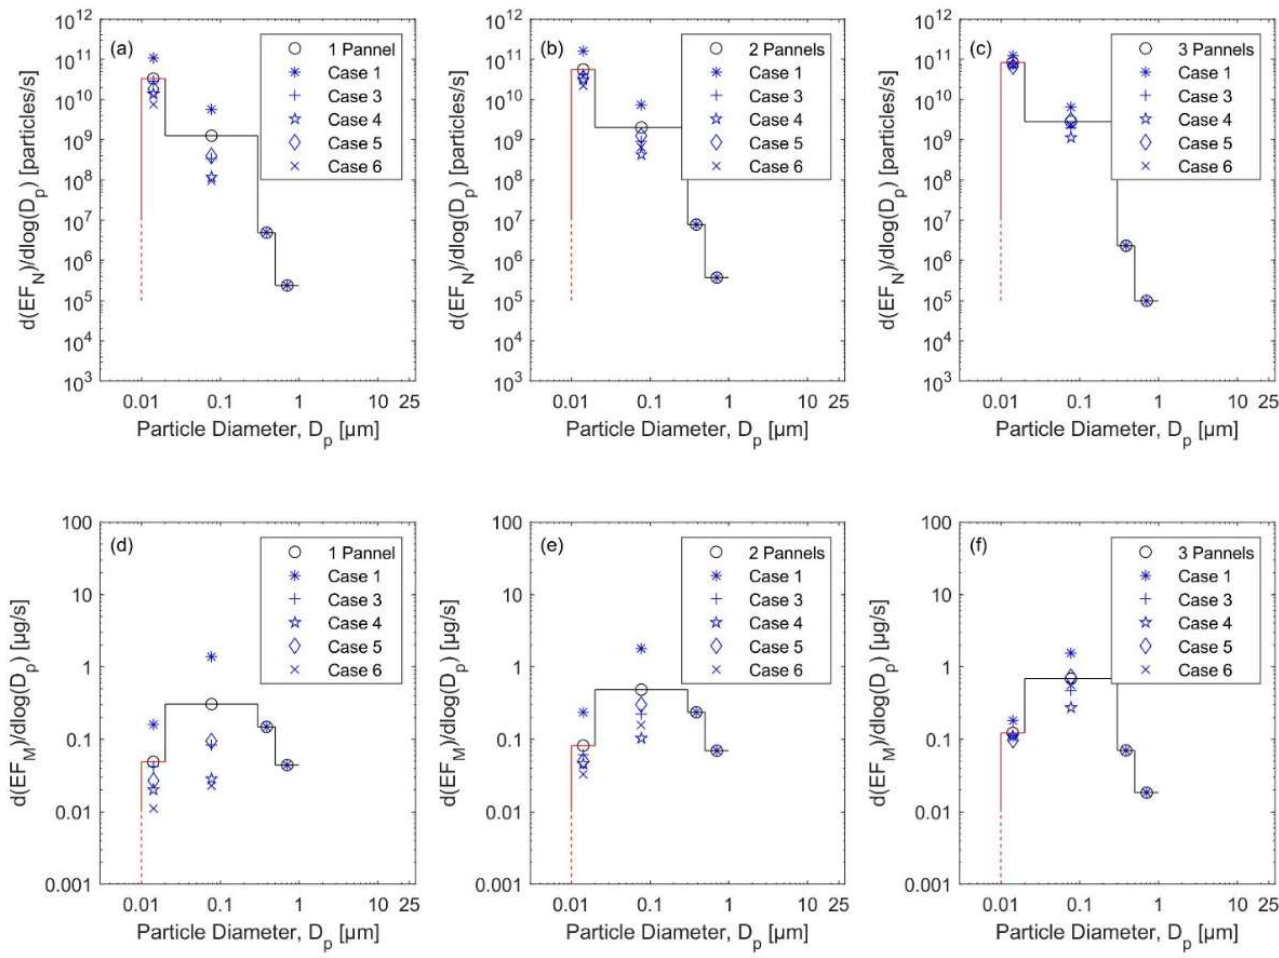
Figure 6. The emission rates during the three scenarios of the natural gas heater operation, presented in the form of ( a – c ) particle number size distributions and ( d – f ) particle mass size distributions. During the steady-state condition, the sources were balanced by the sinks. Assuming ( λ + λ d ) I >> PλO , then Equation (4) reads: